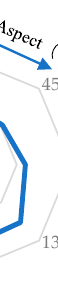
Figure 14. Characteristics of VRR on different slopes.